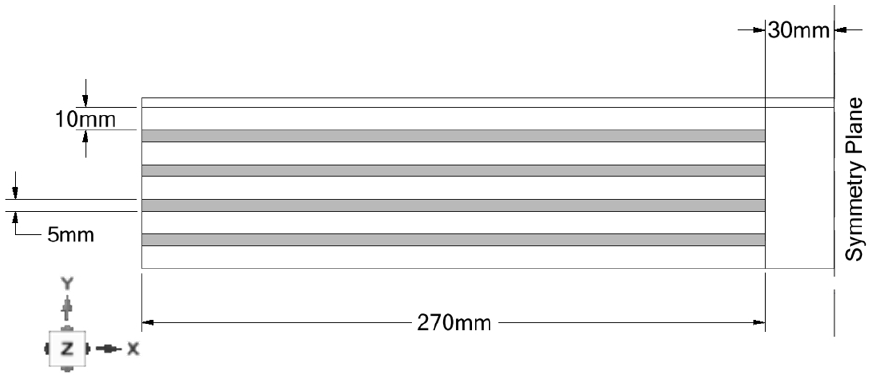
Figure 5. Design of windshield breakwater: ( a ) front view; ( b ) top view; ( c ) side view.